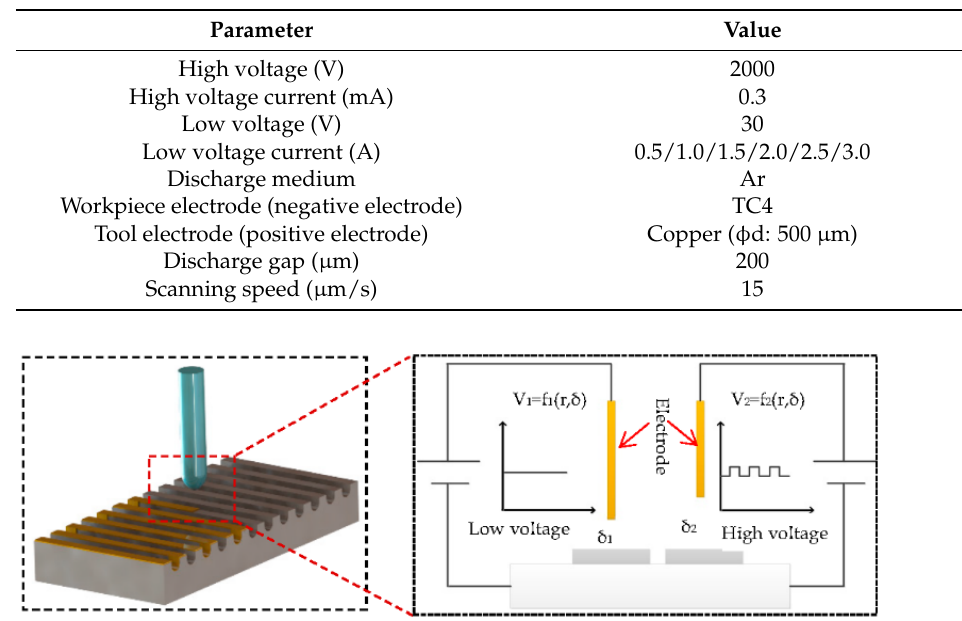
Table 4. Machining parameters of high voltage-induced weak arc discharge.